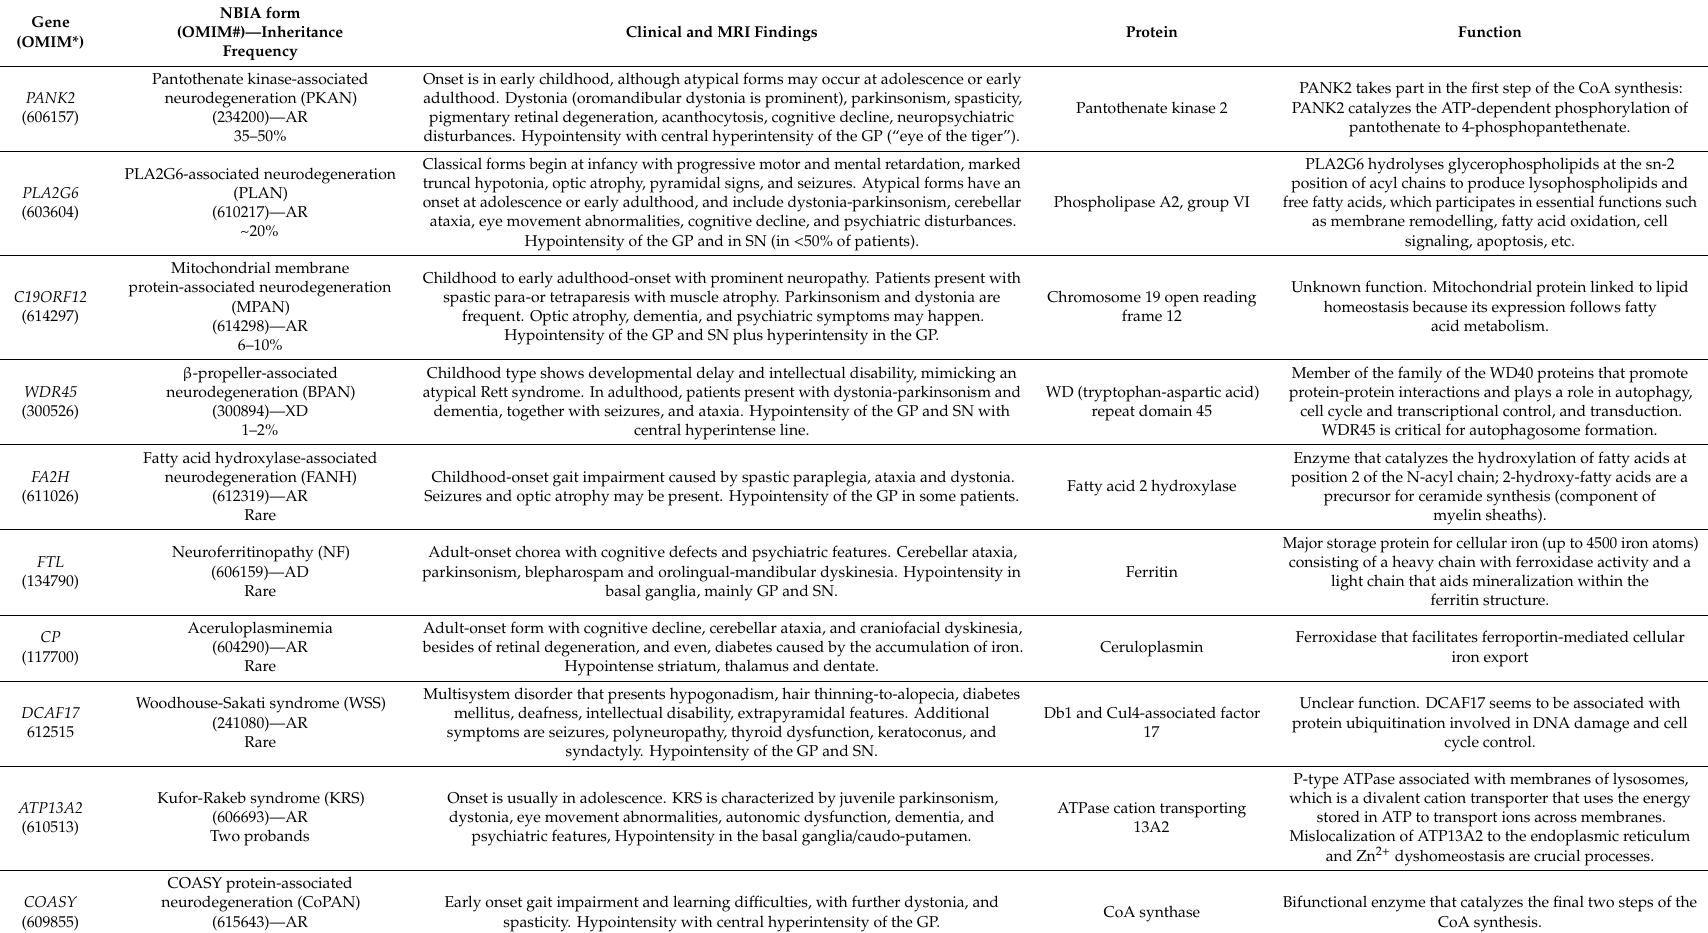
Table 1. The ten classical NBIA